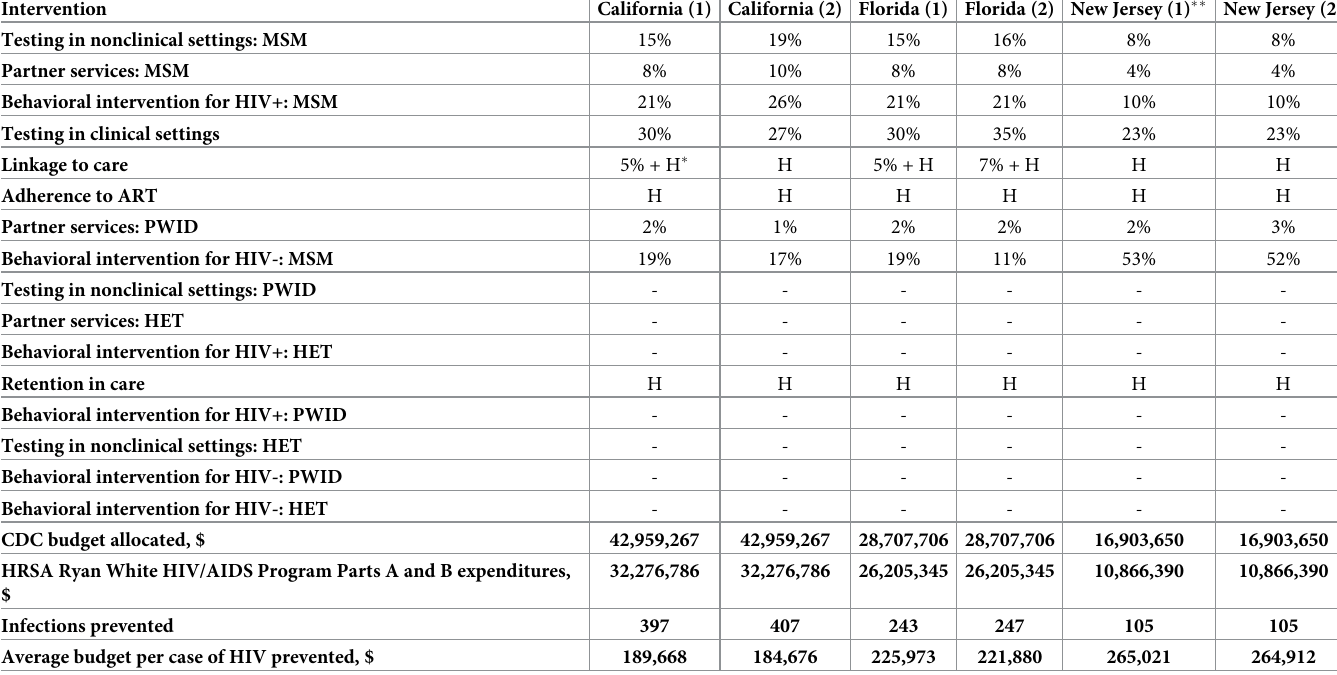
Table 5. Optimal CDC HIV prevention funding allocation for California, Florida and New Jersey: Allocation for high prevalence group versus state-specific characteristics.